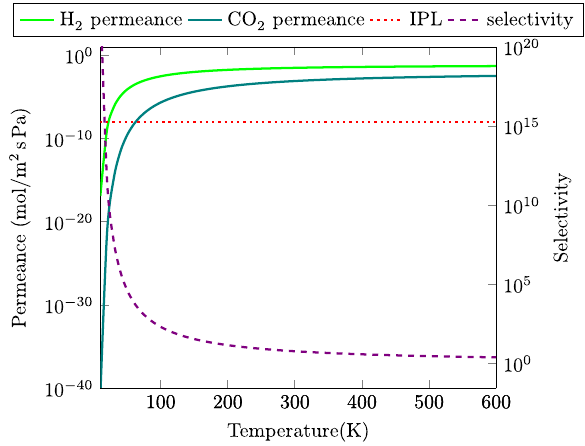
Figure 5. Selectivity of H 2 / CO 2 and permeance of H 2 and CO 2 gases passing through GDY-H membrane as a function of temperature based on DFT calculations. The red dotted plot indicates the industrial permeance limit 10 − 9 mol m 2 sPa 54 (IPL) for the gas separation process which is 6.7 ×